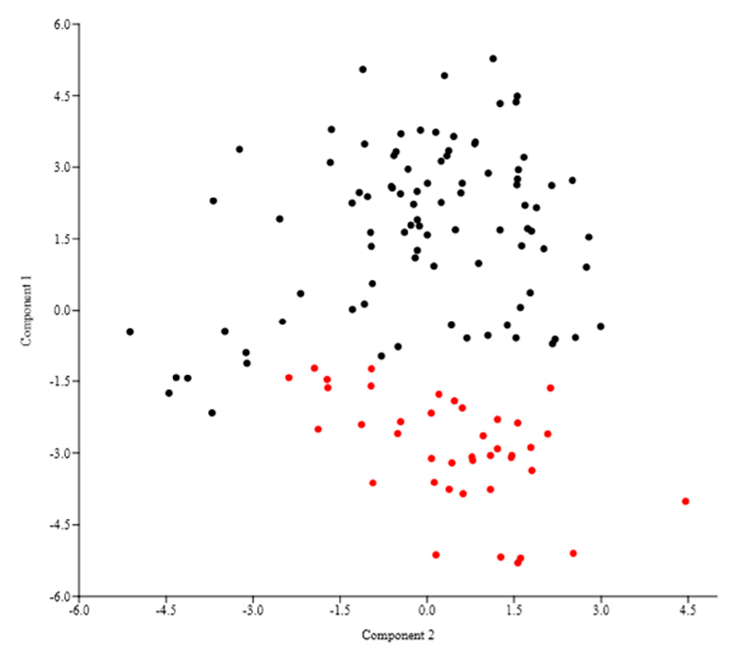
Figure 10. PCA (first (axis x) vs. second (axis y) components) based on the 24 quantitative morpho-